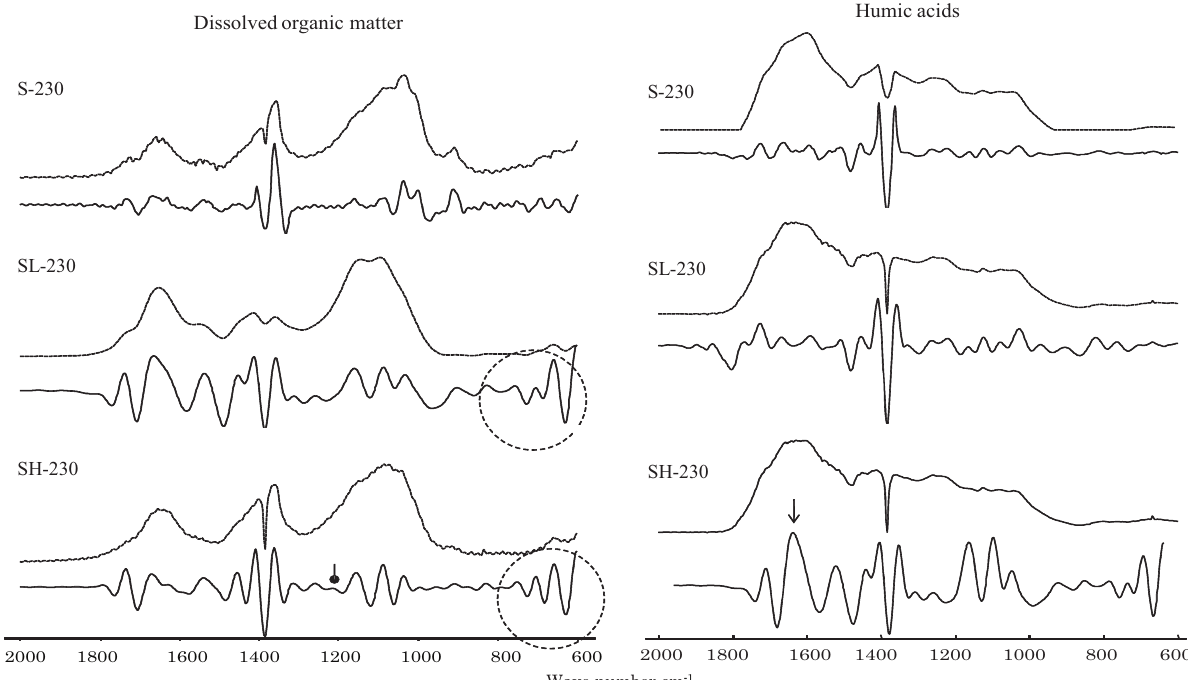
Figure 3. Resolution-enhanced infrared spectra (continuous line) of dissolved organic matter and humic acids from inorganic fertilizer-soil (S-230), sewage sludge-treated soil, low rate (SL-230) and sewage sludge-treated soil, high rate